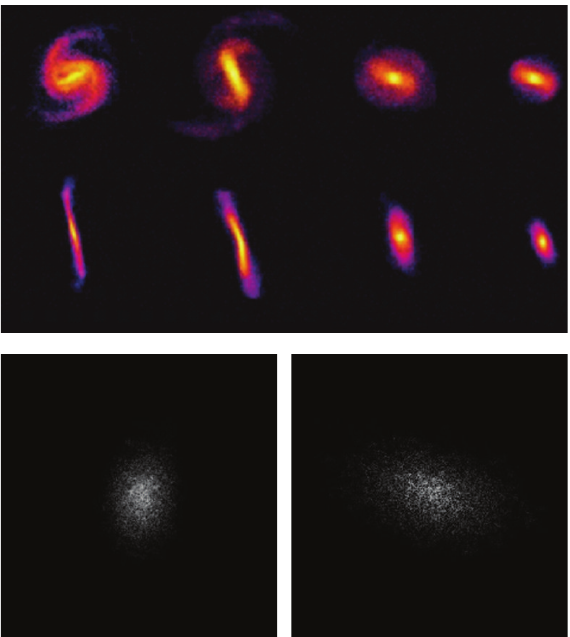
Figure 2: Top: color-coded logarithmic density maps of a tidally stirred dwarf seen face-on (i.e., with the line-of-sight perpendicular to the initial disk orientation, on the top) and edge-on (i.e., with the line-of-sight parallel to the initial disk orientation, on the bottom). The time increases from the left to right; each snapshot is separated by about half an orbital time (the orbital time is ∼ 2Gyr in this simulation), starting with the time corresponding to the first pericenter passage, when the bar first appears. Boxes are 10 kpc on a side. The edge-on view shows clearly the buckling of the bar occurring on the second orbit, and the subsequent transformation into a di ff use spheroidal. Bottom: gray- scale surface brightness maps of the remnant of the simulation shown after 10 billion years of evolution (about 5 orbits). Two perpendicular viewing projections are shown. The limiting B band surface brightness shown in the images corresponds to μ B = 32mag arcsec − 2 , and a B band stellar mass-to-light ratio of 5 was adopted for converting surface mass density into surface brightness (see [14] on models for the evolution of the luminosity and stellar mass-to-light ratio in the tidally stirred dwarf). The faint simulated remnant resembles classic dSphs such as Draco or Carina in both apparent shape and luminosity and surface brightness